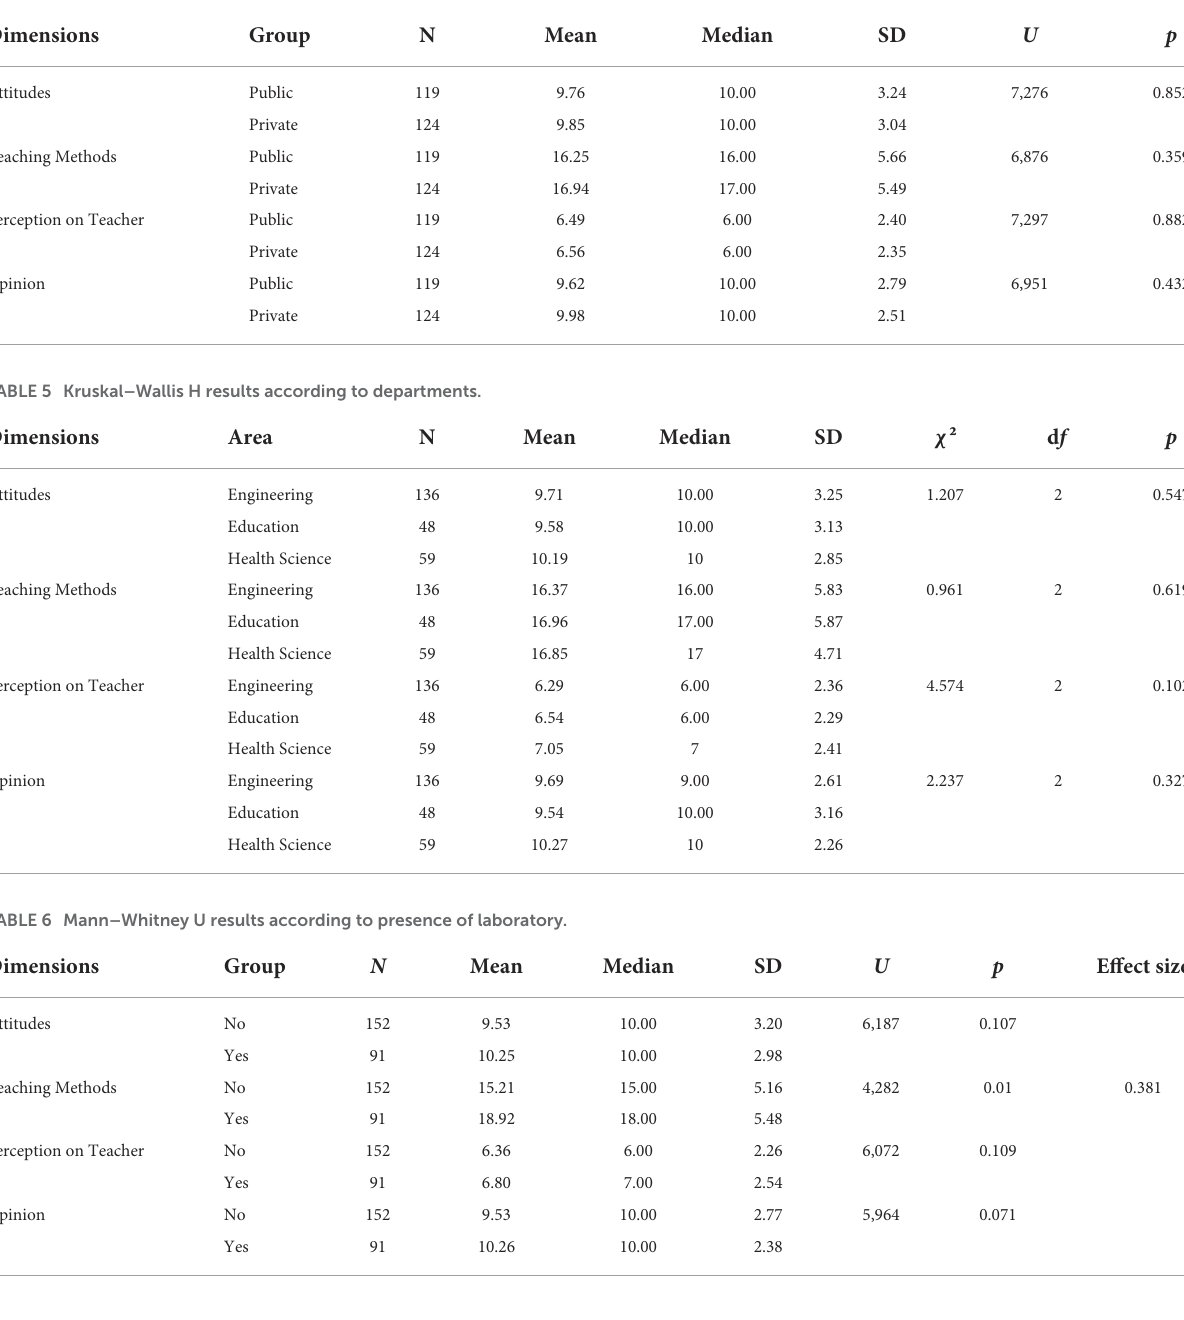
TABLE 4 Mann–Whitney U results according to school status.